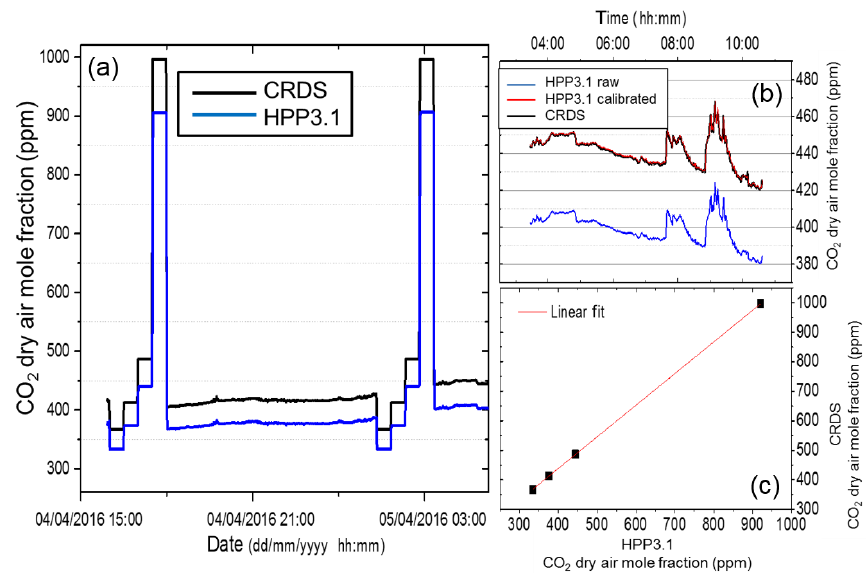
Figure 3. (a) CO 2 dry air mole fractions measured by S1.1 (blue) and the Picarro CRDS analyzer (black). (b) Calibrated dry air mole fractions of S1.1 (red) compared to the raw values (blue). (c) Four reference gases (assigned values are 367, 413, 487 and 997ppm of {CO 2 }) are used for the calibration. No saturation effects are observed within our CO 2 dry air mole fraction